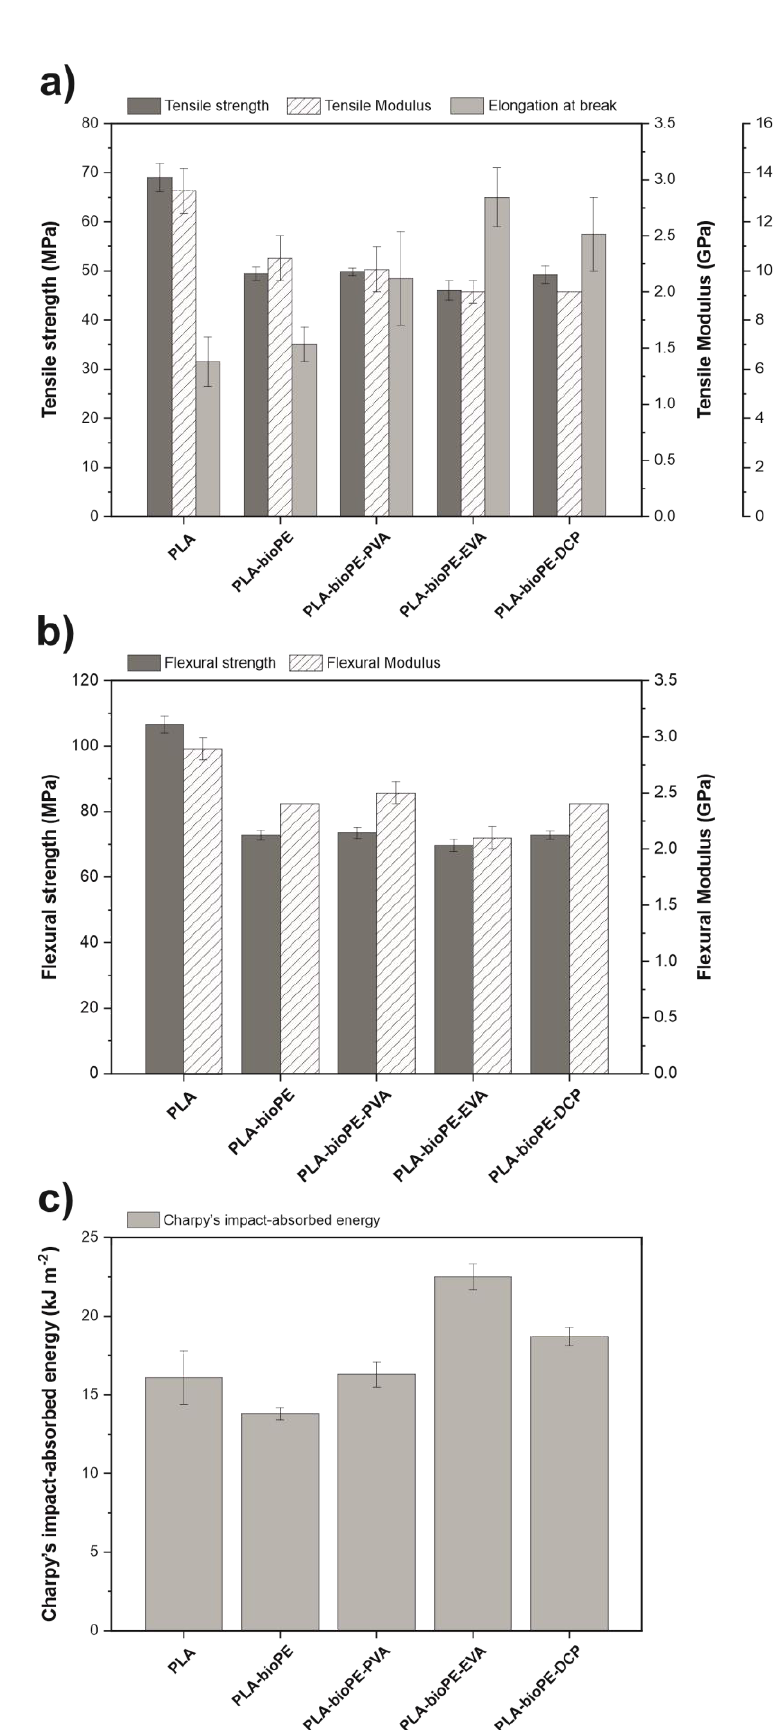
Figure 2. Mechanical properties of neat PLA, PLA-bioPE blend, and PLA-bioPE blend compatibilized with polyvinyl alcohol (PVA), polyethylene vinyl acetate (EVA) and dicumyl peroxide (DCP): ( a ) tensile properties; ( b ) flexural properties; and ( c ) impact properties.